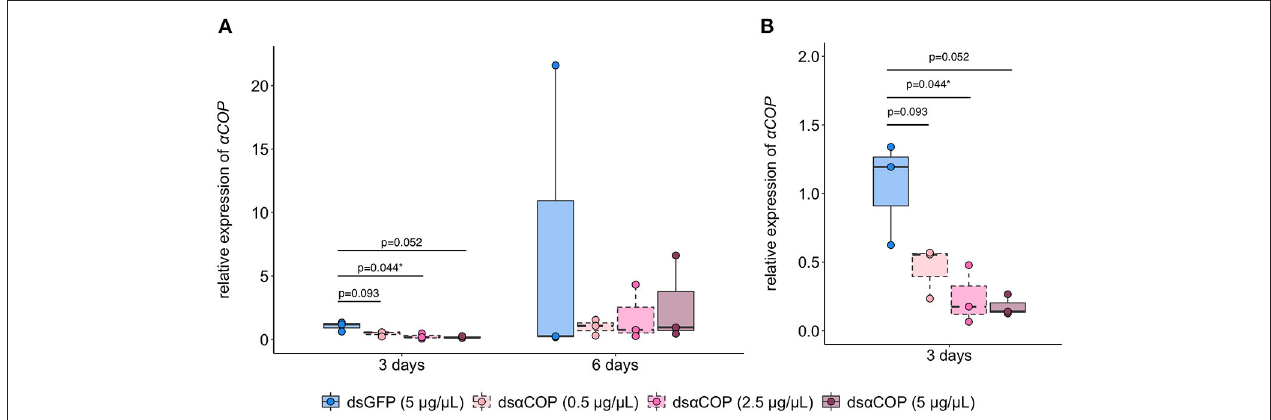
FIGURE 1 | Relative expression of B. aeneus coatomer subunit alpha ( α COP ) in B. aeneus larvae at (A) 3 and 6 d after the start of the experiment; (B) reduced y-axis value-limits, for better visualization of 3 d qPCR data. Data were normalized using the housekeeping genes actin ( act ) and ribosomal protein S3 ( rps3 ). Relative gene expression values were calculated using the 2 − 11 Ct method. n = 3 (3 replicates of 5 larvae) for each time point of analysis within each treatment. Statistical comparisons were made via Welch’s t -test. An asterisk indicates a significant difference between ds α COP and dsGFP treatment. * = p < 0.05.